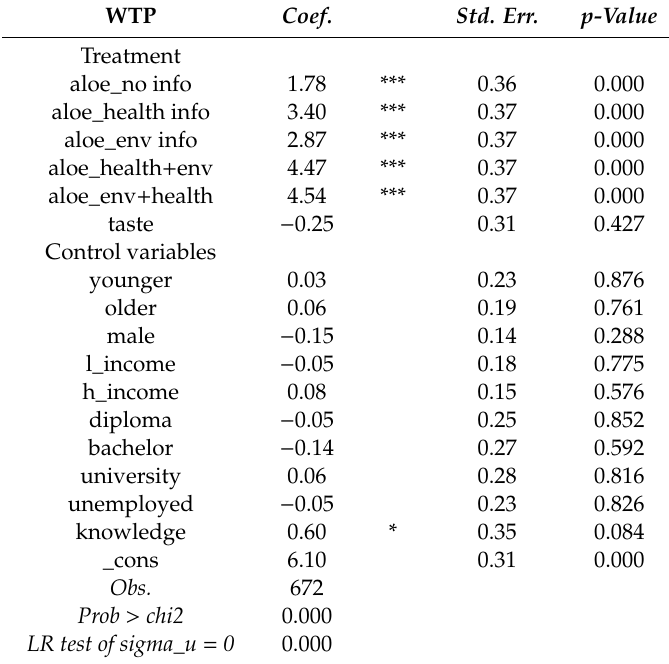
Table 4. Tobit model with random e ff ect for the WTP for the fruit compote (Model 2). WTP Coef. Std.